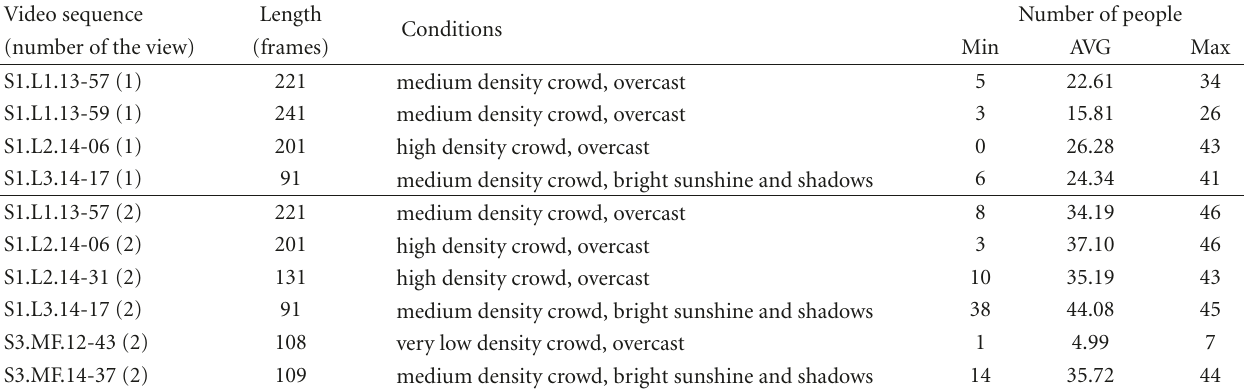
Table 1: Relevant characteristics of the four sequences of the PETS 2009 datasets used for assessing the performance of the proposed method. Video sequence